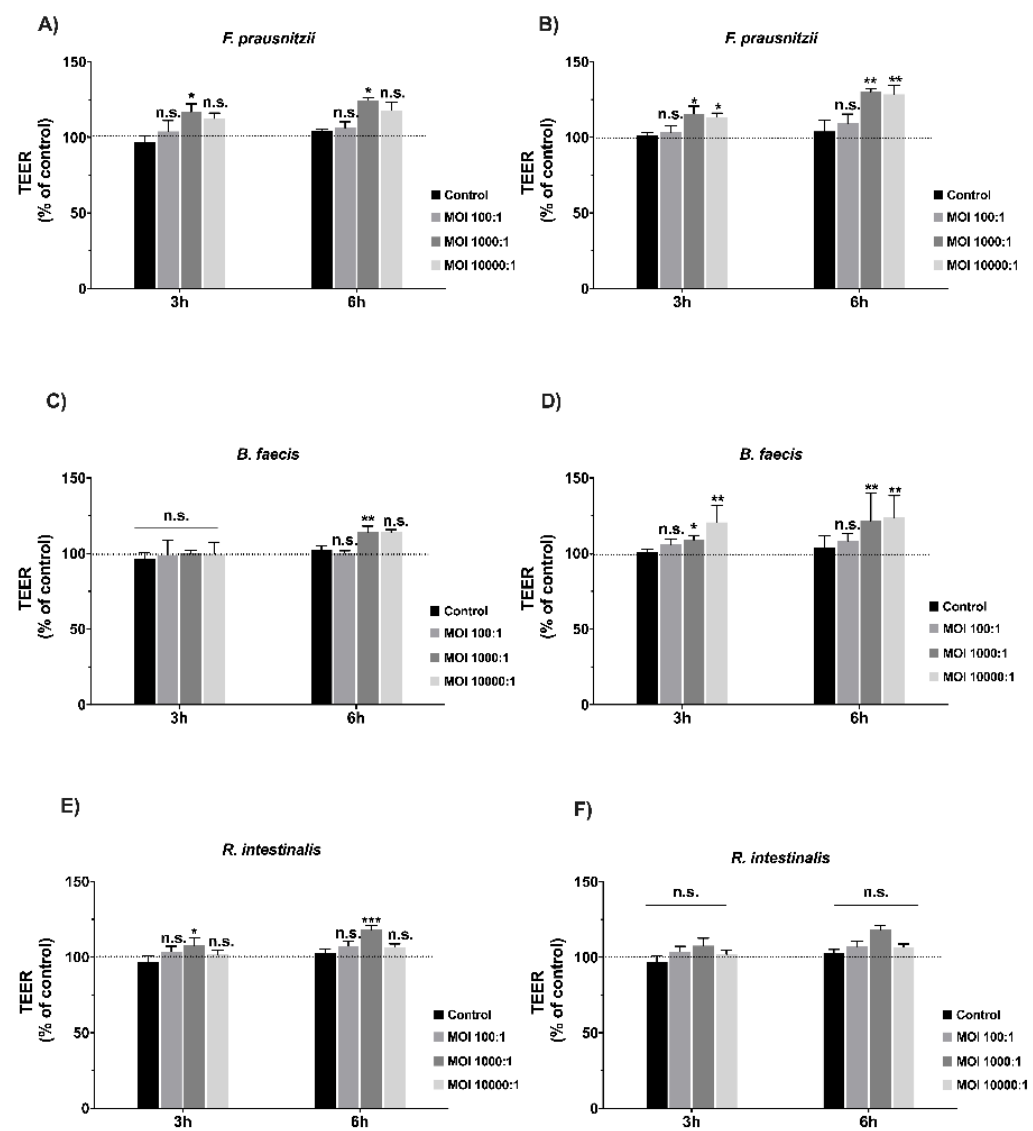
Figure 1. Effect of F. prausnitzii , B. faecis and R. intestinalis on the transepithelial electrical resistance (TEER) of epithelial cells. Caco-2 ( A , C , E ) and HT29-MTX ( B , D , F ) cell monolayers were incubated with all three bacterial species at three different multiplicities of infections (MOIs) in an anaerobic chamber. The transepithelial electrical resistance (TEER) was measured 3 and 6 h after the cells’ exposure to bacteria. Results are represented as the means ± SD ( n ≥ 5). Data were analyzed with the Mann–Whitney U-test, * p ≤ 0.05, ** p ≤ 0.01, *** p ≤ 0.001; n.s., not statistically significant.